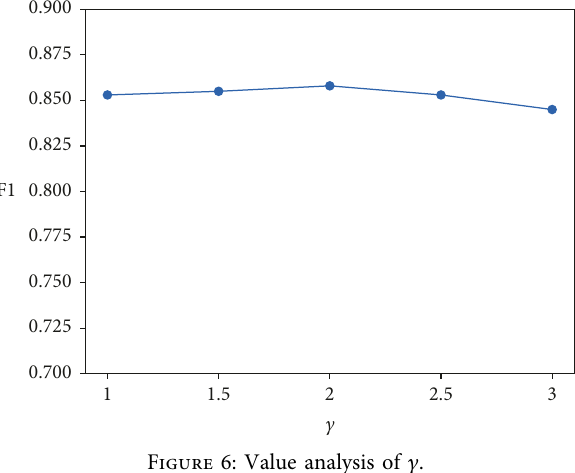
Figure 6: Value analysis of c .